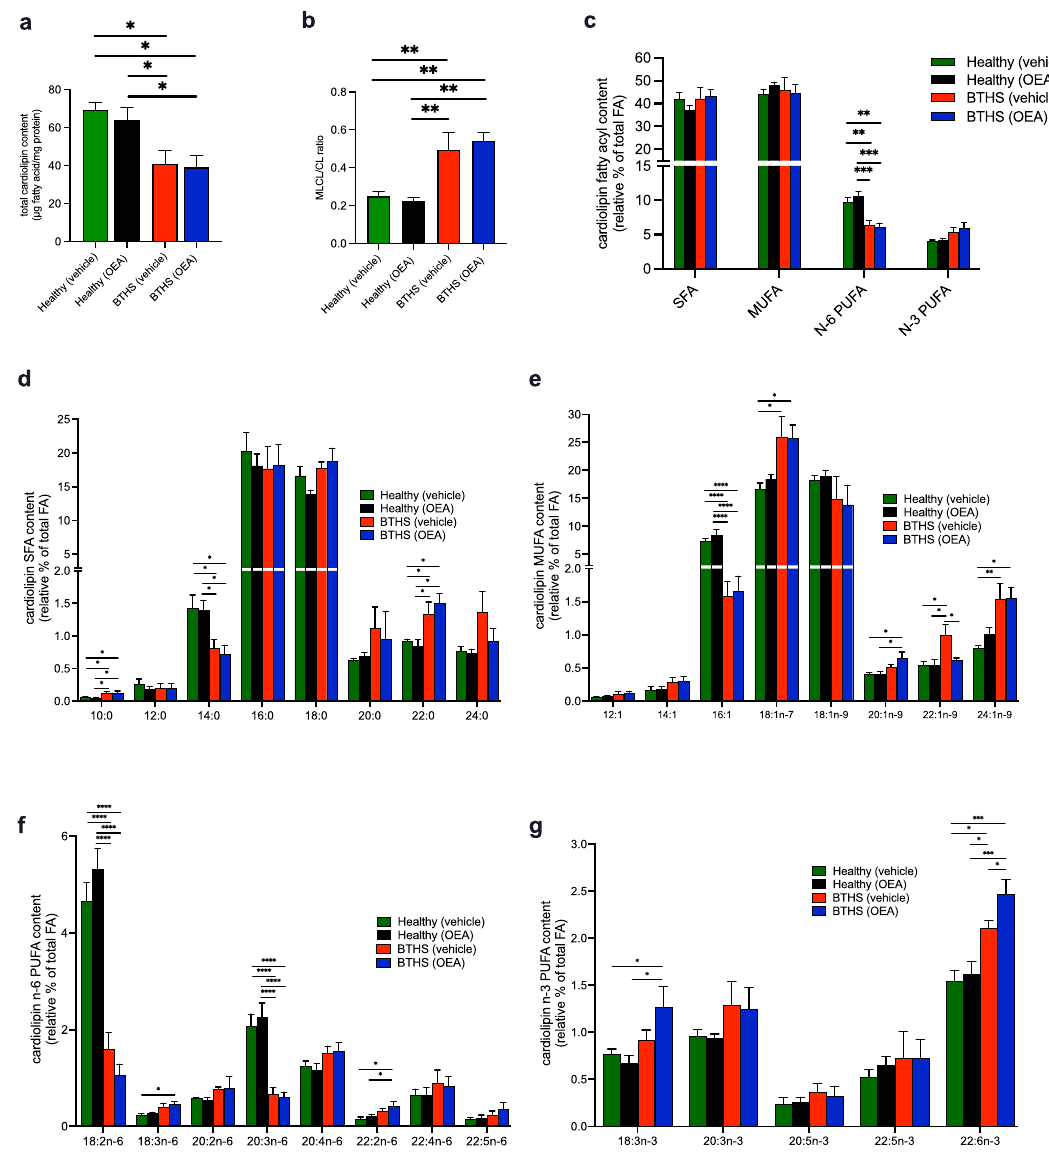
Figure 3. OEA does not restore total cardiolipin content or MLCL:cardiolipin ratio in BTHS lymphoblasts. Total cardiolipin content ( a ), MLCL:cardiolipin ratio ( b ), cardiolipin fatty acyl (FA) content by major categories ( c ), and cardiolipin relative contents of saturated (SFA) ( d ), monounsaturated (MUFA) ( e ), n-3 polyunsaturated (N-3 PUFA) ( f ) and n-6 polyunsaturated (N-6 PUFA) ( g ) fatty acyl species. Data are means ± S.E.M; n = 5. *P < 0.05, **P < 0.01, ***P < 0.001, ****P <